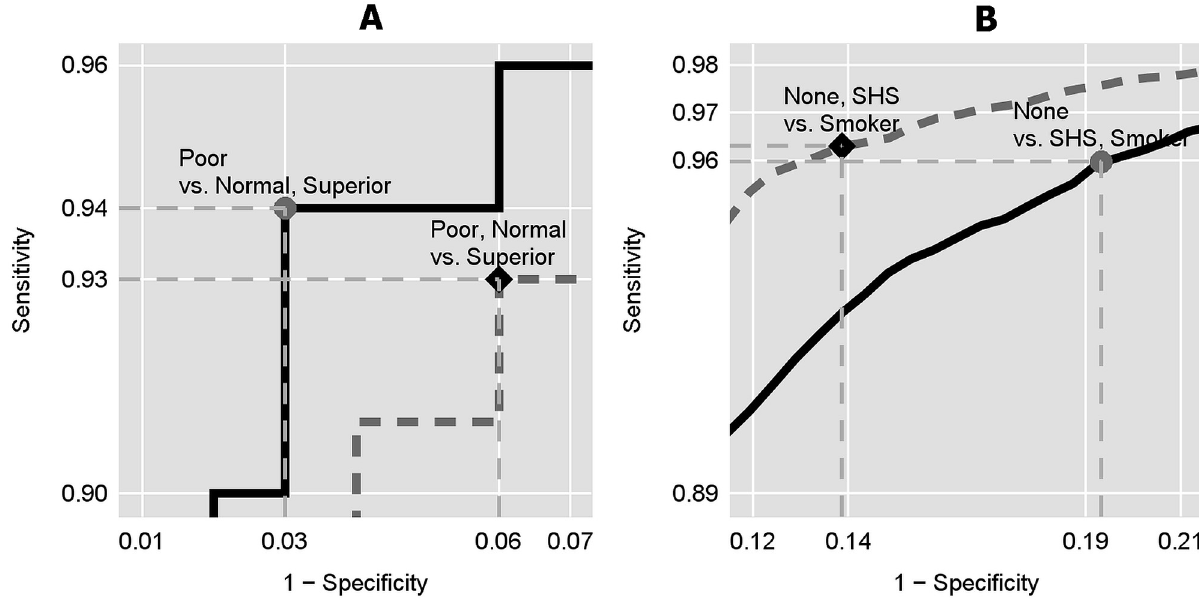
Fig 2. Cumulative ROC curves (focused on upper-left quadrant) indicating coordinates for Total Accuracy cutpoints. A: Cork Stopper Quality: poor vs. normal, superior quality (solid line) and poor, normal vs. superior (dashed line). B: NHANES Tobacco Smoke Exposure: none vs. second-hand smoke (SHS), smoker (solid line) and none, SHS vs. smoker (dashed line).